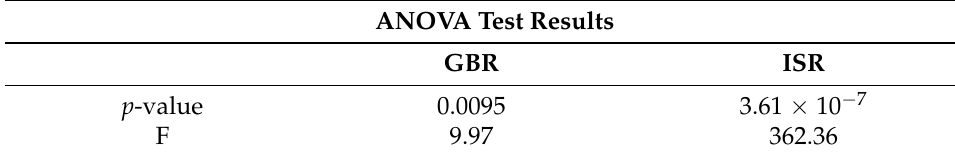
Table 7. ANOVA test results for GBR and ISR.